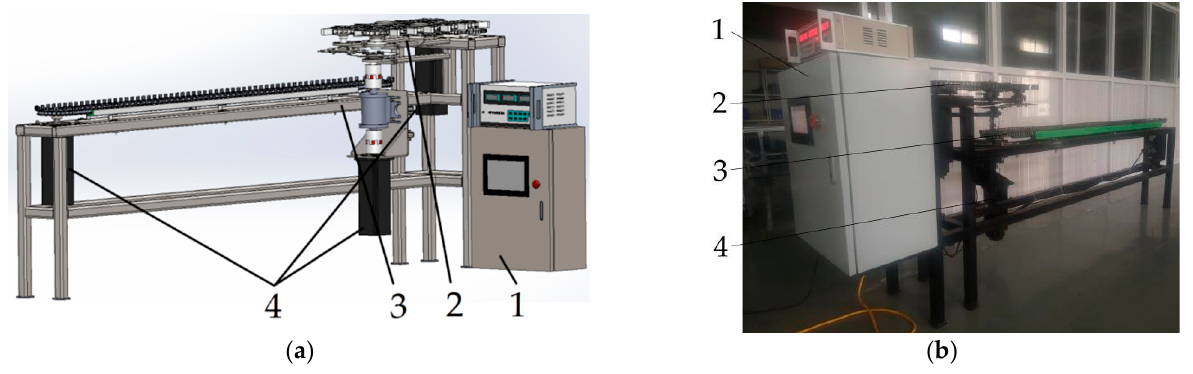
Figure 8. Verification test device. ( a ) Schematic diagram. ( b ) Cutting test bench—1. measurement and control system; 2. cutting system; 3. feeding device; and 4. dynamical system.